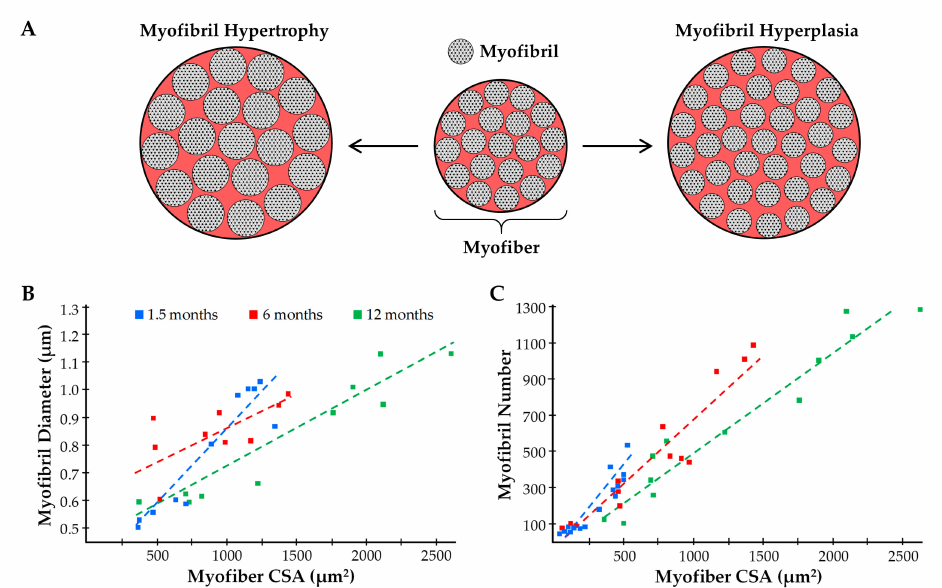
Figure 7. ( A ) Illustration of how an increase in the CSA of the pre-existing myofibrils (myofibril hypertrophy) and an increase in the number of myofibrils (myofibril hyperplasia) can contribute to the radial growth of myofibers. ( B , C ) Summary of the data from Goldspink (1970) which highlights the relationship that exists between myofiber CSA and myofibril diameter ( B ), as well as myofiber CSA and myofibril number ( C ), in mice of various ages